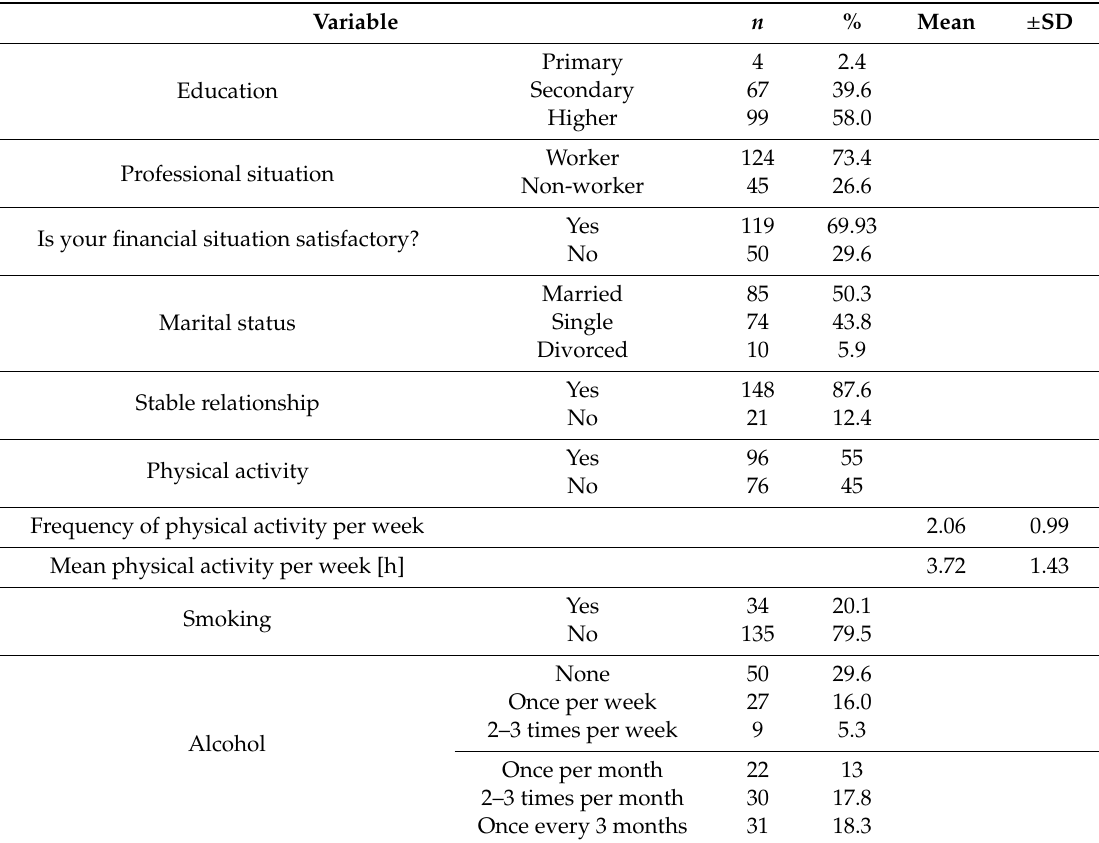
Table 1. Sociodemographic characteristics of the studied patients.